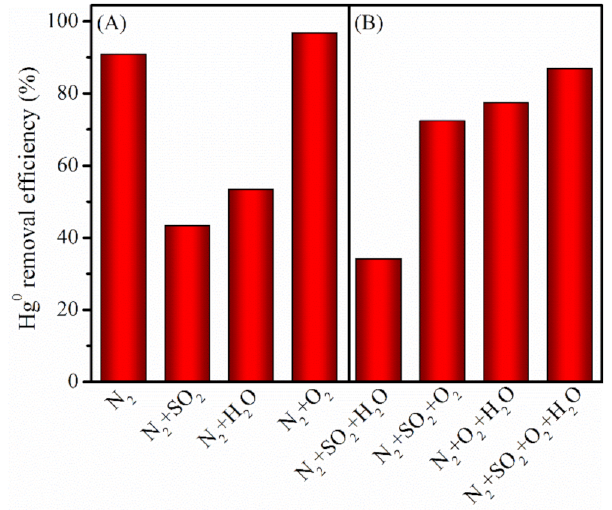
Figure 4. Effect of flue gas components on Hg 0 removal over 5V 2 O 5 /PG (( A ) single component; ( B ) multi-components. reaction conditions: O 2 = 8%, H 2 O = 5%, SO 2 = 0.15%, N 2 as balance, C Hg0 = 240 µ g/m 3 , GHSV = 6000 h − 1 , T = 150 ◦ C).